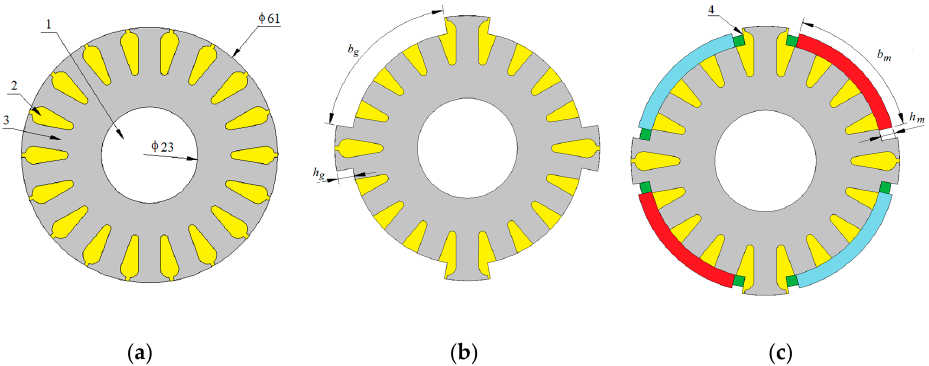
Figure 2. Structure of the rotor: ( a ) rotor from an induction motor; ( b ) rotor with milled gaps; ( c ) rotor with mounted permanent magnets (1—shaft, 2—rotor core, 3—aluminum bars, 4—non-magnetic wedge).